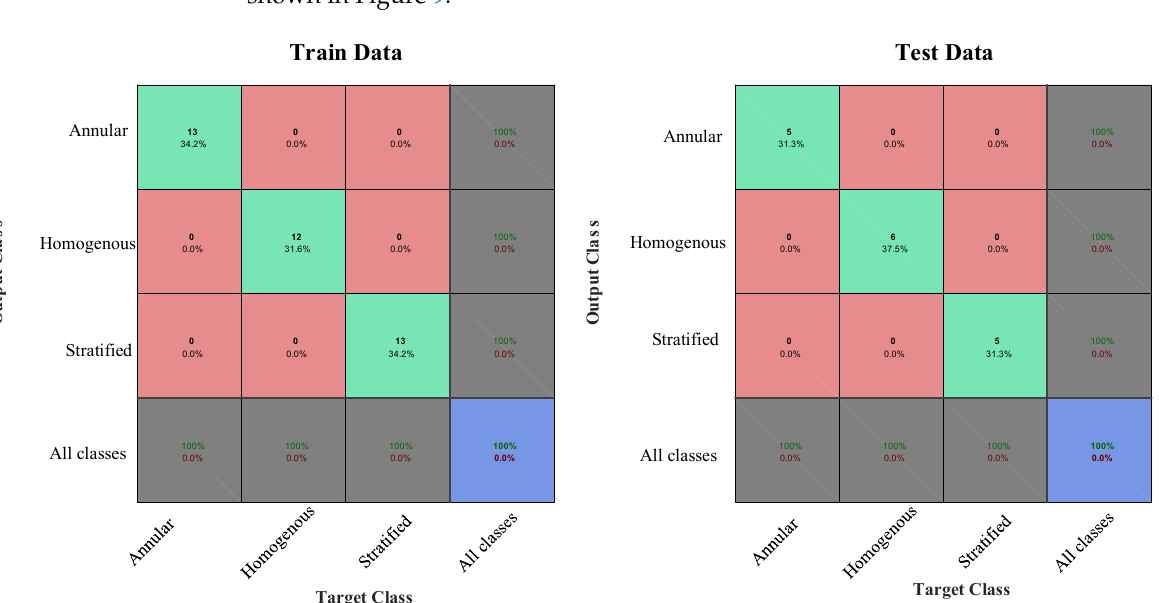
Figure 9. Confusion matrix for regime classification (training and testing data samples).